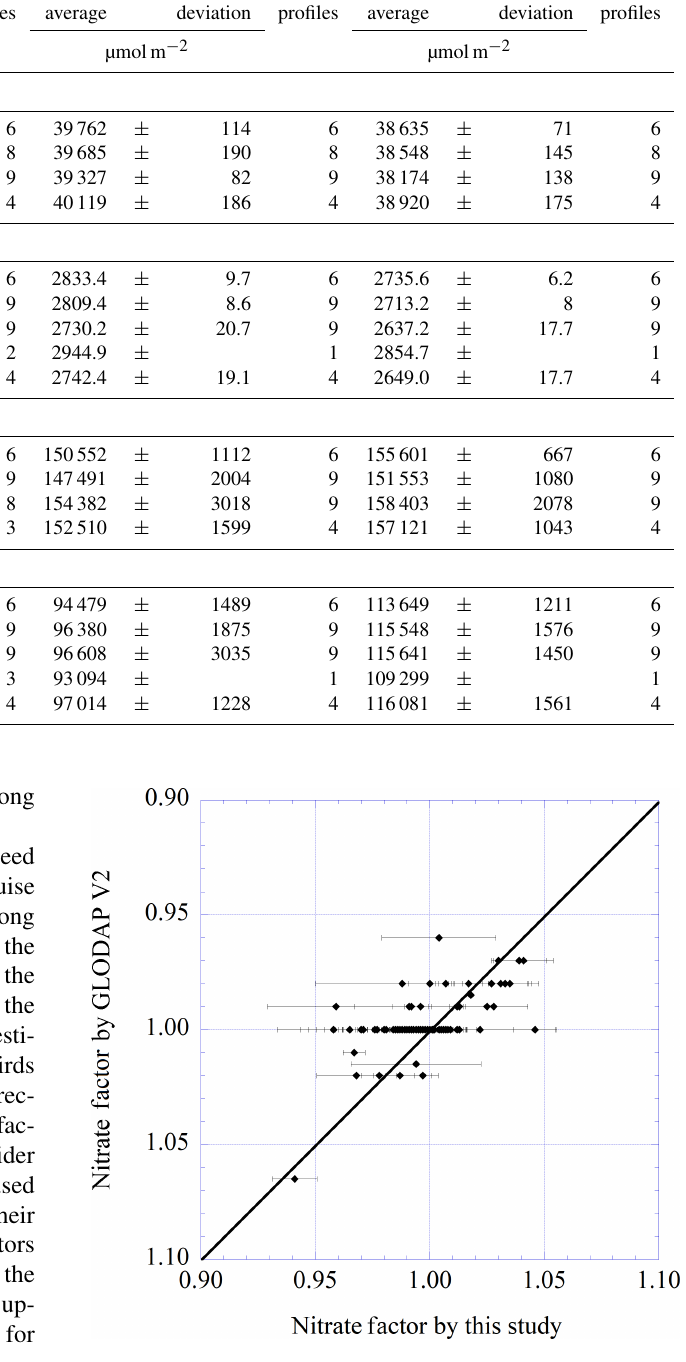
Figure 8. A comparison of correction factors for nitrate by this study with uncertainties and by GLODAP